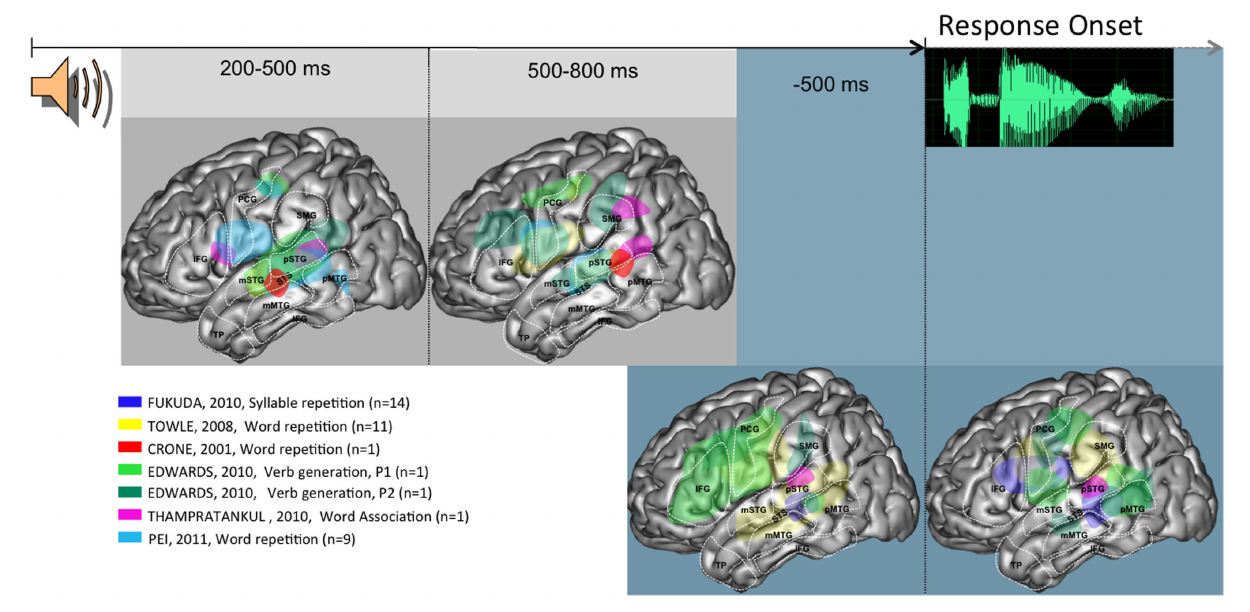
FIGURE 1 | Summary of activities observed across patients and studies when language production is triggered auditorily, projected on a standardized left hemisphere. The two figures on the gray background represent activities time-locked to stimulus presentation, at the indicated timings.The two figures on the blue background represent activities time-locked to response onset. Further details are provided in the Section